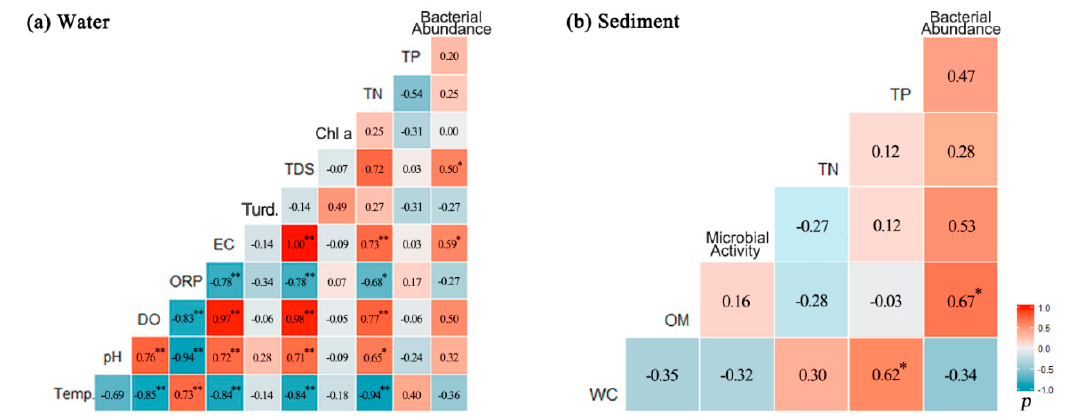
Figure 5. Pearson’s correlation coefficient among environmental parameters in water ( a ) and sediment ( b ). * p -value < 0.05, ** p -value < 0.01. EC: electric conductivity; Turd.: turbidity; Temp.: water temperature; WC: water content; OM: organic matter; ORP: oxidation–reduction potential.